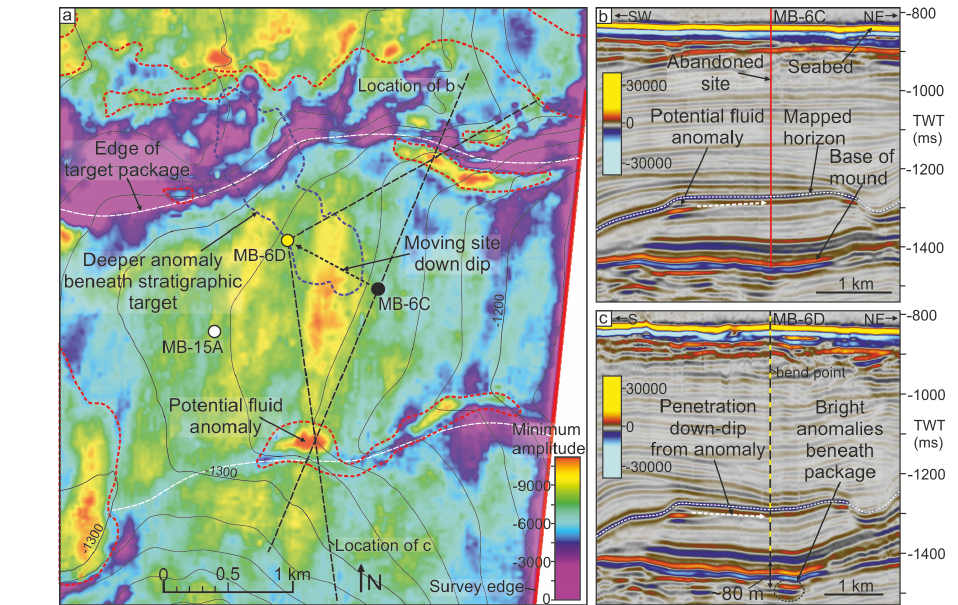
Figure 13. Target VI. (a) A minimum amplitude attribute extraction along a mapped horizon representing the top of the contourite mound package that constitutes Target VI (horizon shown in panels b and c ). The attribute extraction highlights bright amplitudes that may represent either tuning or fluid anomalies. The spatial relationship between these bright anomalies and fluid anomalies extracted through the shallow gas detection process (red dashed polygons) (displayed in Fig. 3) is highlighted. The Target VI site locations are shown as well as the locations of panels (b) and (c) . The location of panel (a) is shown in Fig. 6. (b) A seismic cross section from the Anu survey showing the contourite mound that comprises Target VI. The occurrences of the potential fluid anomalies are also displayed along with the location of abandoned site MB-6C. (c) A seismic cross section from the Anu survey showing the location of the Target VI primary site MB-6D. The site location is shown to penetrate the top mound horizon down dip from the potential fluid anomalies on the packages’